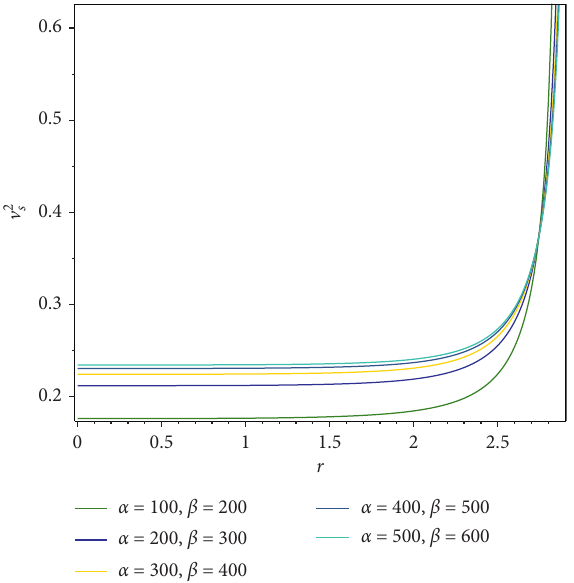
Figure 9: Variation of speed of